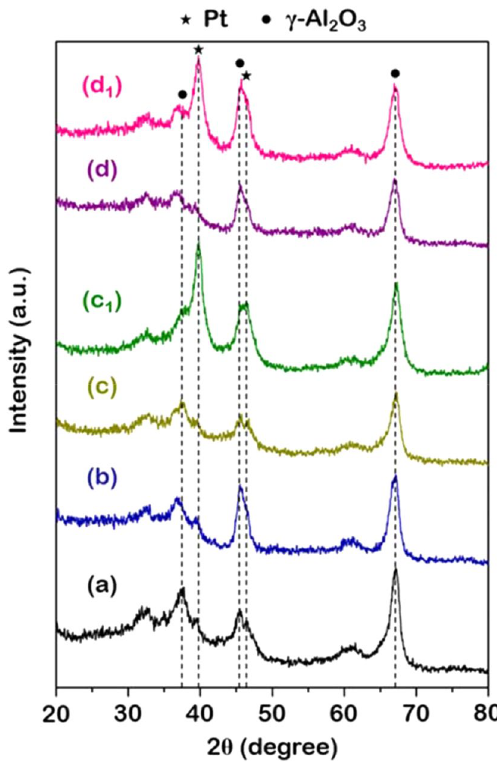
Figure 2. XRD patterns of ( a ) γ-Al 2 O 3 , ( b ) WO x /γ-Al 2 O 3 , ( c ) fresh Pt/γ-Al 2 O 3 , ( c 1 ) reused Pt/γ-Al 2 O 3 , ( d ) fresh